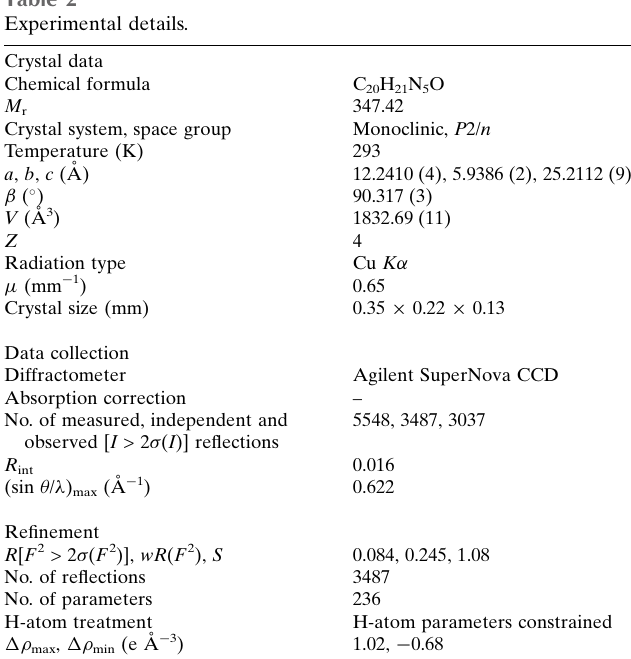
Table 2 Experimental details.